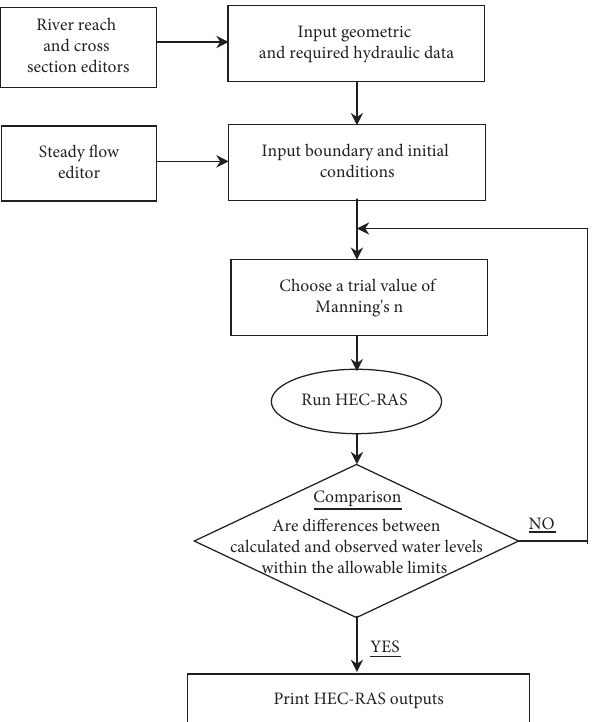
Figure 5: Calibration